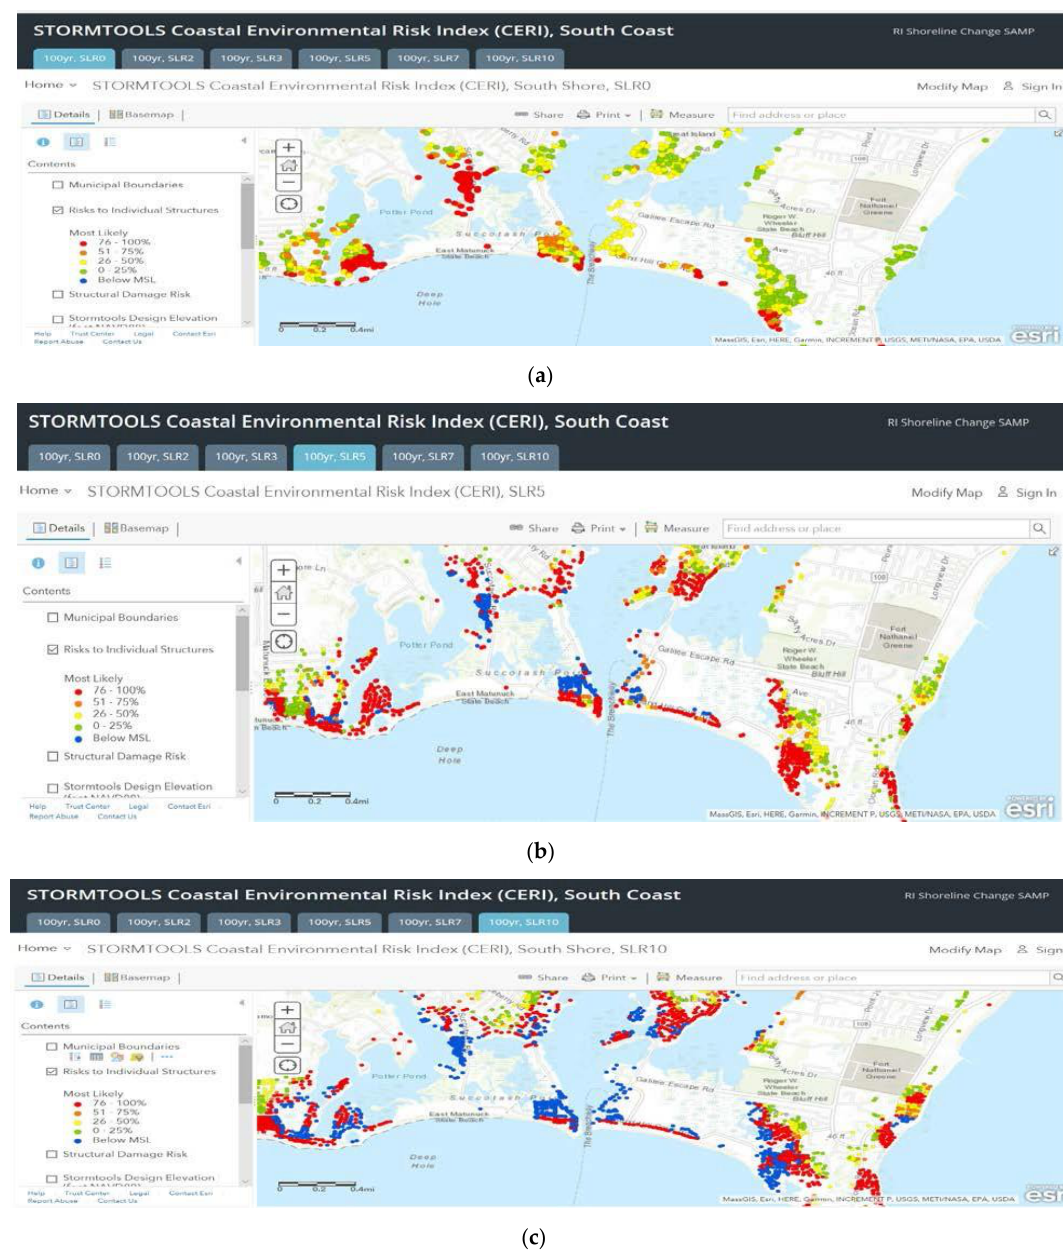
Figure 8. CERI predicted for 100 yr surge and varying SLR cases, ( a ) none (upper panel), ( b ) 5 ft (center panel), and ( c ) 10 ft (lower panel) for the area in the immediate vicinity of the Port of Galilee. Legend shown on left.